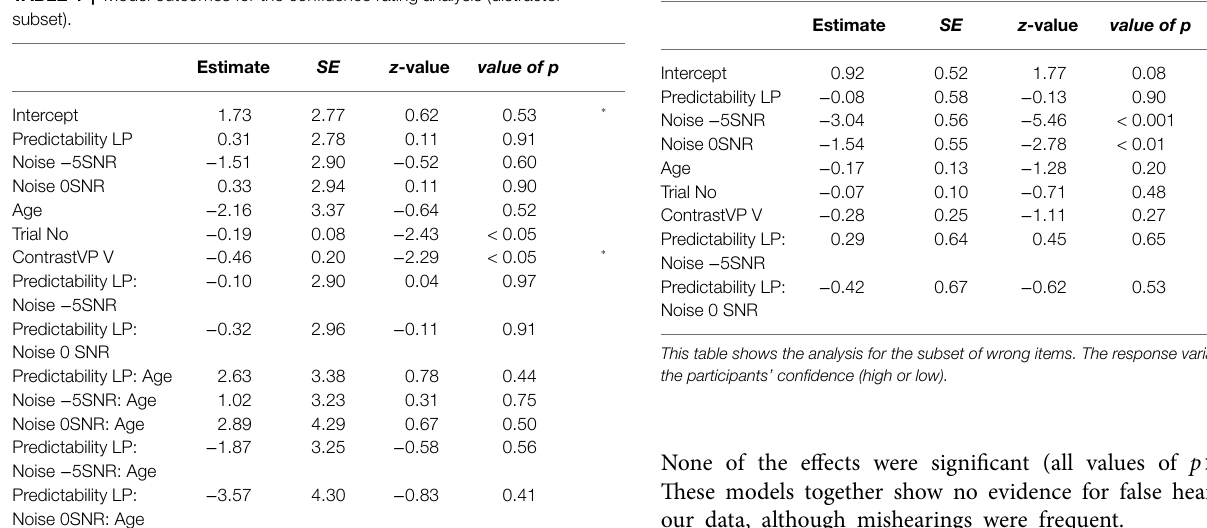
TABLE 5 | Model Outcomes for the confidence rating analysis (wrong